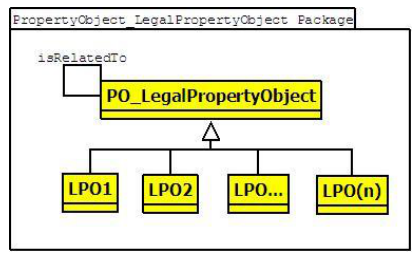
Figure 6. PO_LegalPropertyObject Package